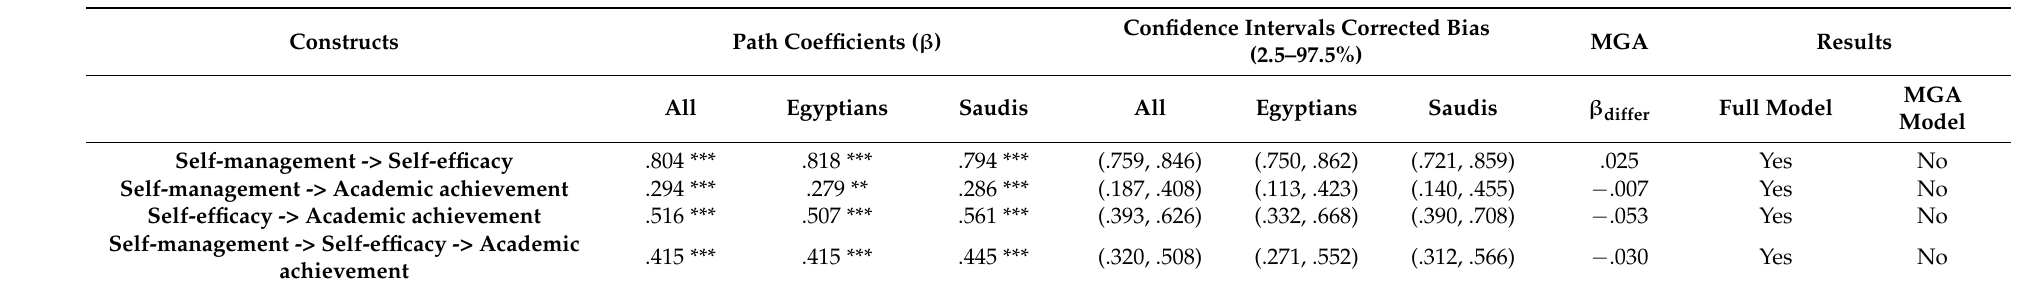
Table 5. Results of